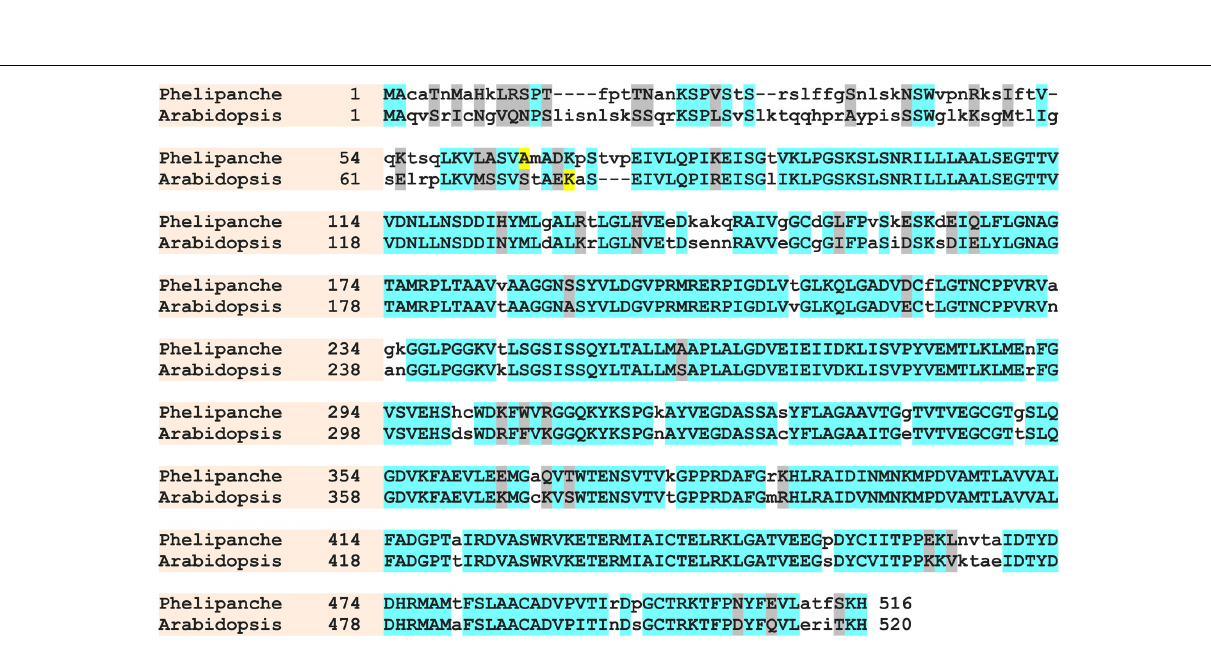
FIGURE 2 | Amino acid sequence alignment of A. thaliana ( Arabidopsi s) and P. aegyptiaca ( Phelipanche ) EPSPS. Identical and similar amino acids are shown in azure and gray, respectively. Non-identical amino acids are shown in lowercase letters. First amino acids of predicted mature protein are shown in